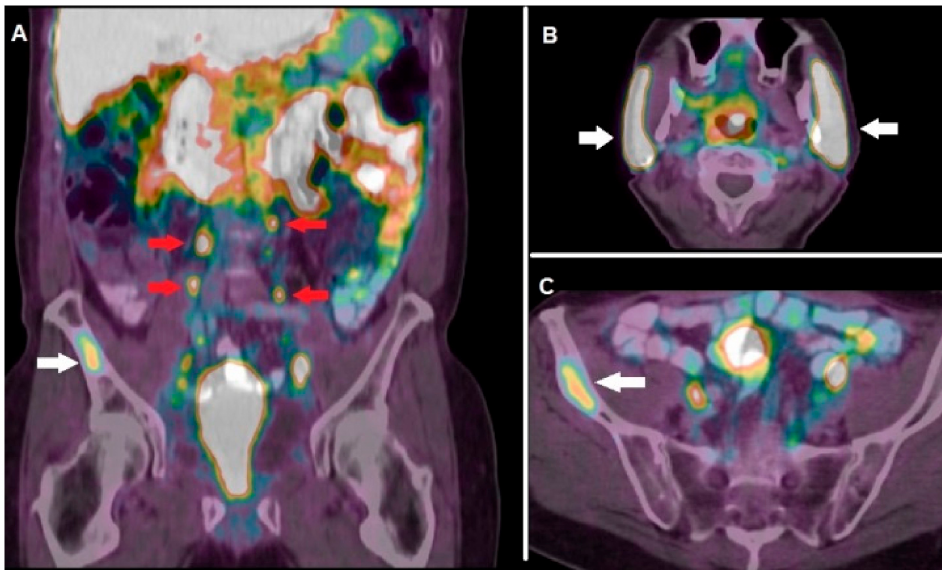
Figure 2. A 74-year-old patient affected by mCRPC (Gleason score 5 + 4), progressing after surgery, androgen deprivation therapy (ADT) and chemotherapy, submitted to PET/CT with 68 Ga-PSMA- 11 before enrollment for 177 Lu-RLT. Coronal fused images ( A ) showed highly increased tracer incorporation in abdominal lymph nodes (red arrows) and in the right iliac bone (white arrow). Note the intense physiological radiopharmaceutical uptake in salivary glands ( B ), white arrows), while fused axial image of the pelvis well demonstrates 68 Ga-PSMA-11 uptake in the iliac metastasis ( C ) white